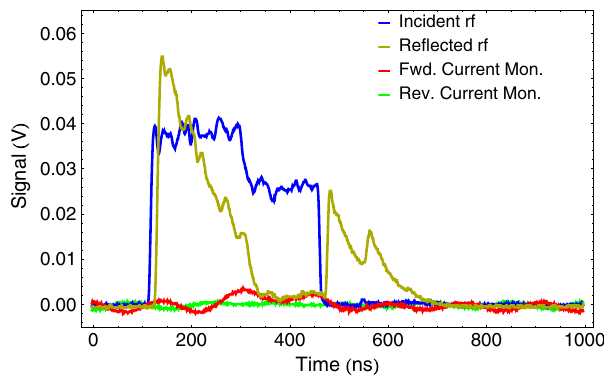
FIG. 11. A sample set of scope traces showing a normal shot. This is a 150 ns shot at approximately 125 MV = m gradient. The measured incident rf signal is shown in blue, and the measured reflected rf signal is shown in yellow. The forward and reverse current monitor signals are shown in red and green, respectively.